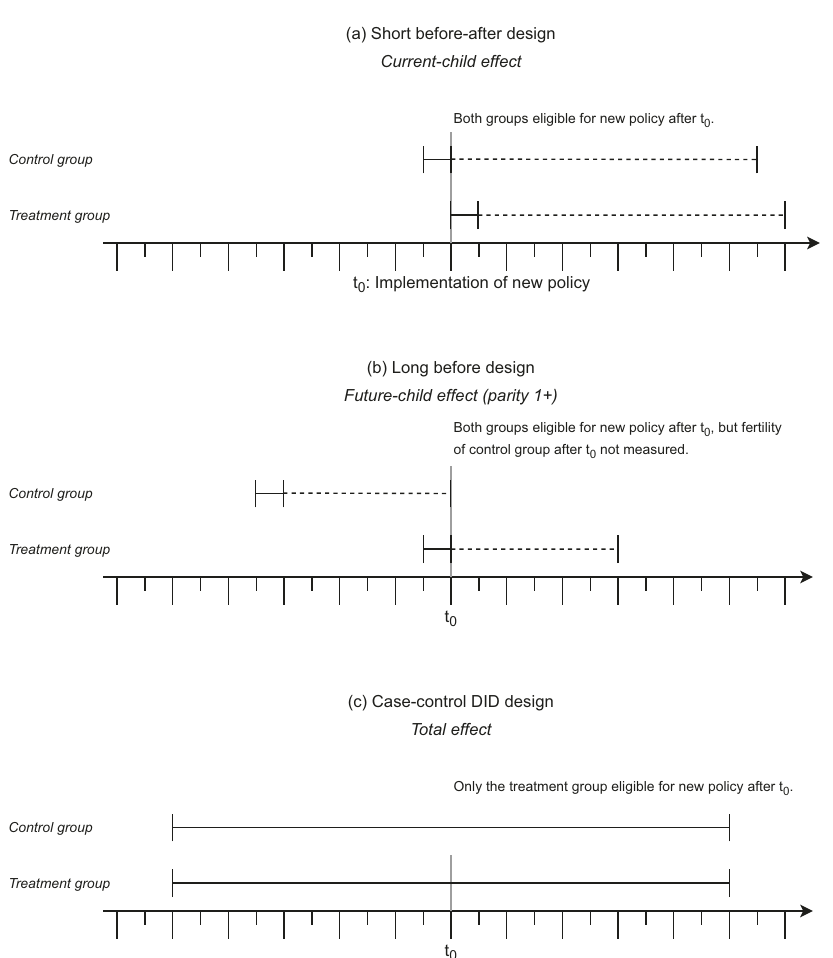
Fig. 3 Study designs for evaluating the effects of leave on fertility. a The short before-after study design, used to evaluate the current-child effect. b The long before study design, used to evaluate the future-child effect on individuals of parity 1 or higher. c The case-control difference-in-differences study design, used to evaluate the total effect. Long check marks on the horizontal axis indicate years, and short check marks indicate half-years. Solid horizontal lines indicate data on births being collected at that time, and dashed horizontal lines indicate that data on births occurring at that time will be collected